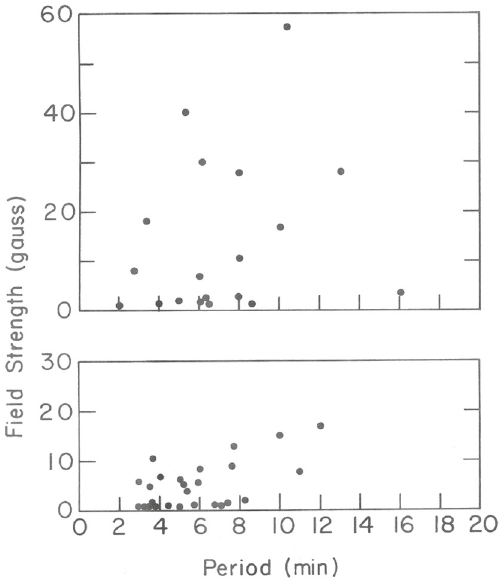
Fig. 11 Period of prominence Doppler velocity oscillations as a function of the line-of-sight magnetic field strength. The top and bottom panels correspond to active region and non-active region prominences, respectively. Image reproduced with permission from Harvey